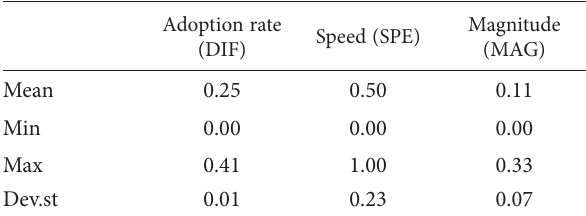
Table 4. Statistics of the dependent